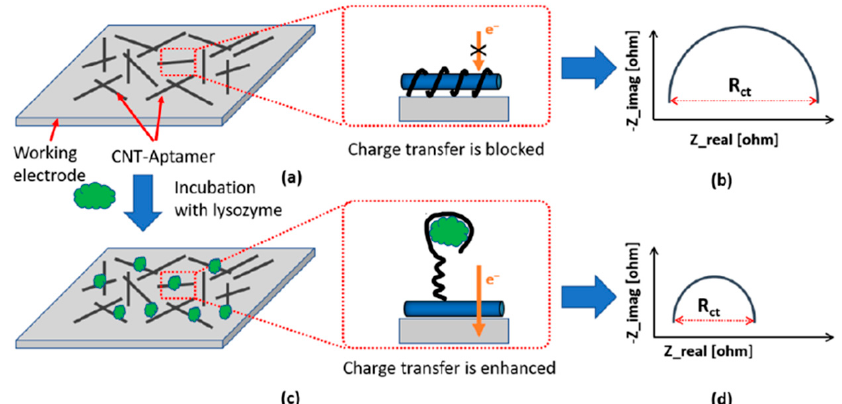
Figure 2. ( a , b ) Electrochemical immunosensor for Brettanomyces bruxellensis at a SPCE nanostructured with AuNPs-rGO and further modified with 3-MPA and enzymatic labelling with ConA-HRP. Reprinted and adapted from [75] with permission.